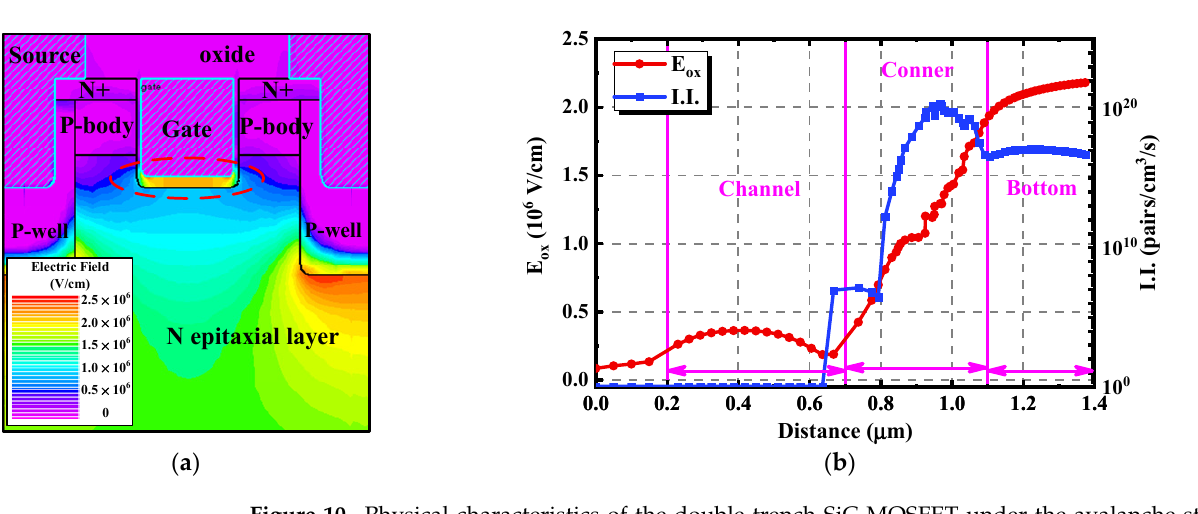
V ds (V) Original After 5k cycles After 10k cycles Figure 9. Variations of the C gd of the double-trench SiC MOSFET under different avalanche stress cycles . 3.2. Simulations and Analysis Simulations were then performed to help analyze the various degradation trends be- tween the two types of devices with different structures. Figure 10a reflects the electric field distribution of the double-trench SiC MOSFET under the avalanche state. The highest